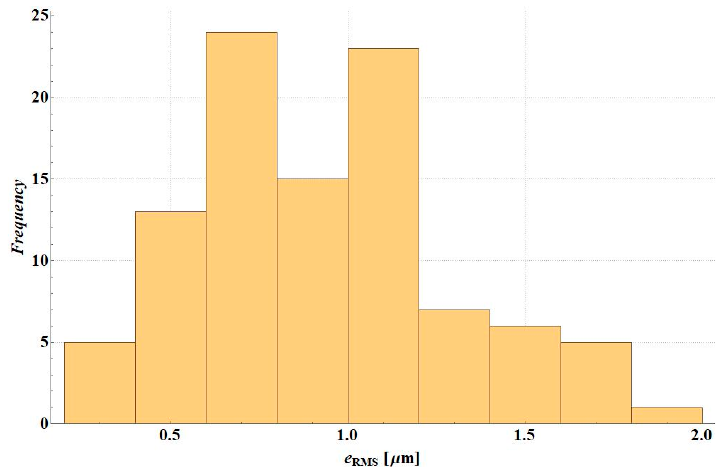
Figure 8. e RMS error histogram for D1S variant.